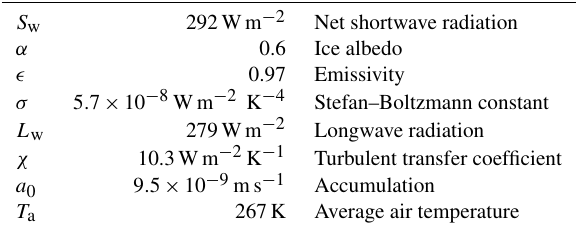
Table 2. Typical numerical values for the surface energy balance (Cuffey and Paterson, 2010; van den Broeke et al.,